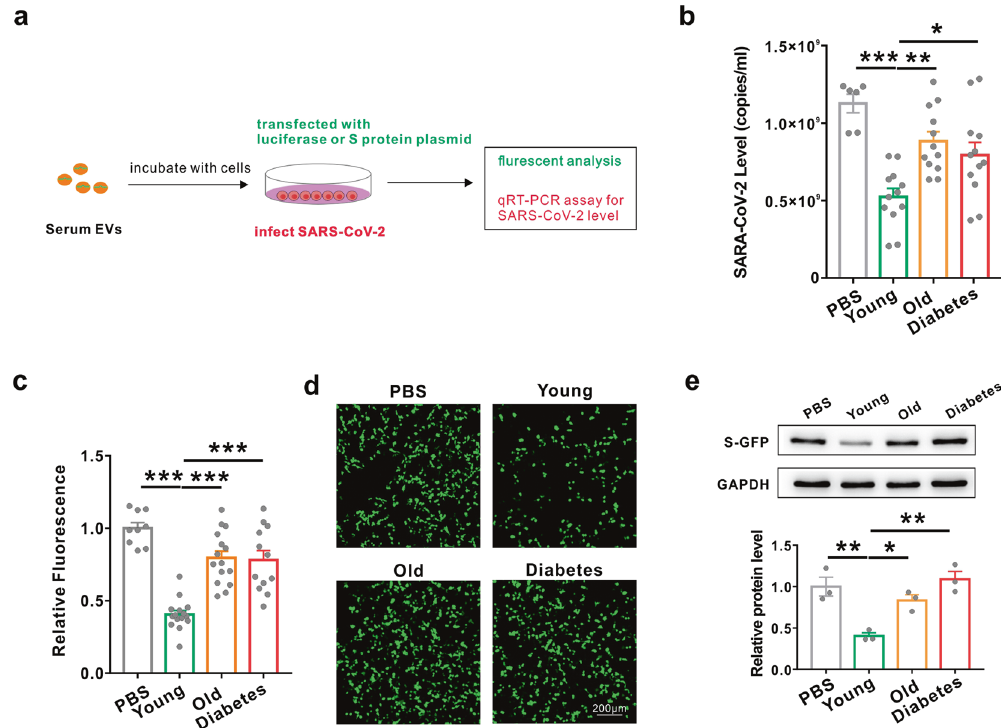
Fig. 3 The inhibitory effects of circulating exosomes on SARS-CoV-2 replication were decreased in elderly people and diabetic patients. a Diagrams of the collection of exosomes from serum in young, elderly and diabetic groups and the measurement of the biological activities of exosomes in inhibiting S protein expression and SARS-CoV-2 replication. b Ef fi cacy of exosomes collected from young, elderly and diabetic groups in inhibiting the replication of SARS-CoV-2. c , d , e Cytometric analysis ( c ), fl uorescence images ( d ) and western blot ( e ) of GFP-S protein-overexpressing HEK293T cells after treatment with PBS and serum exosomes collected from the young, elderly and diabetic groups. Data are shown as means ± SEMs. Statistical signi fi cance was assessed using one-way ANOVA coupled with Bonferroni ’ s post hoc test ( b , c , e ). * P < 0.05; ** P < 0.01; *** P <